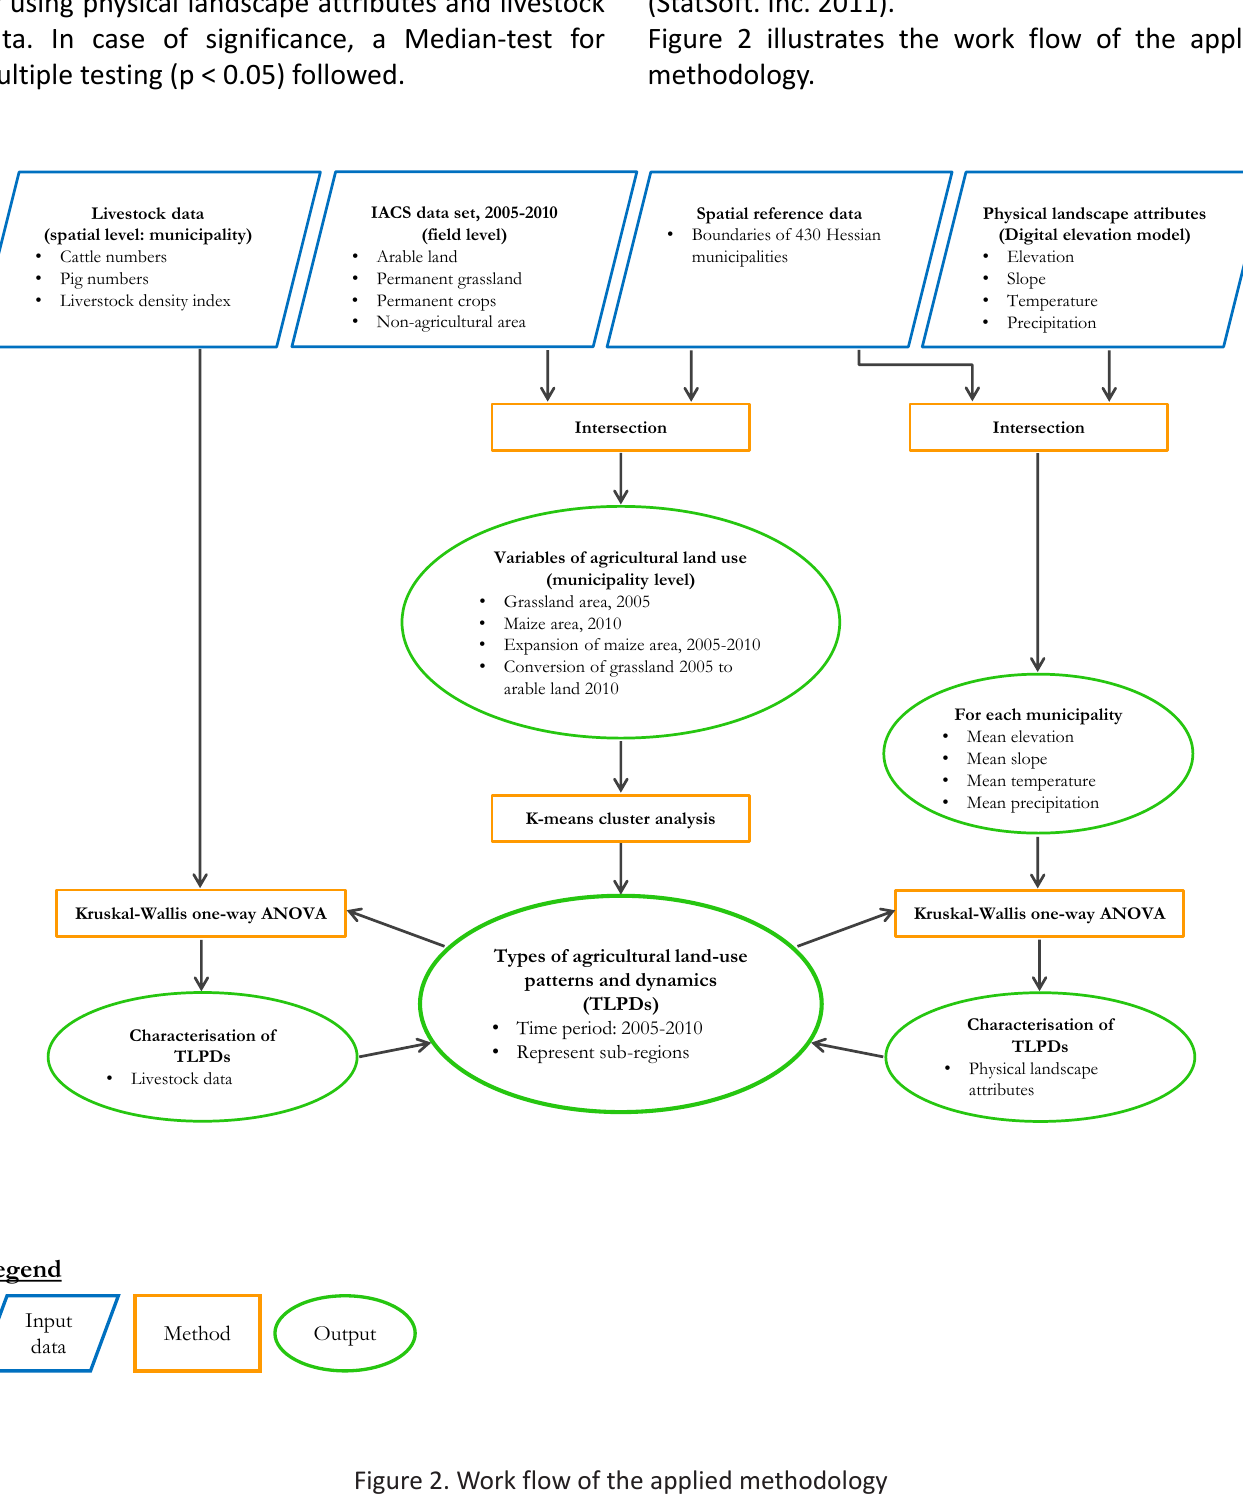
Figure 2. Work flow of the applied